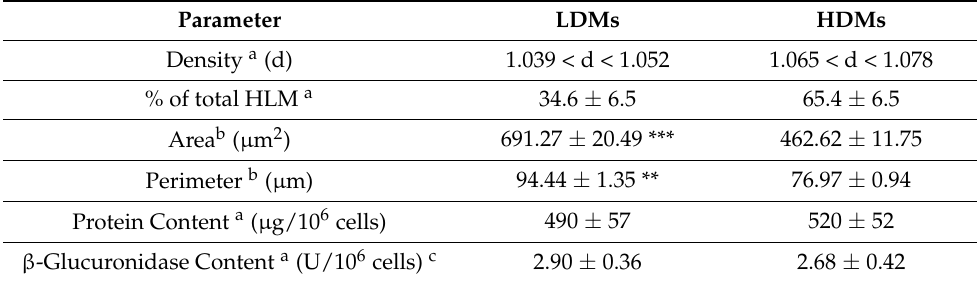
Table 1. Morphometric and biochemical characteristics of macrophage subpopulations in the human lung.